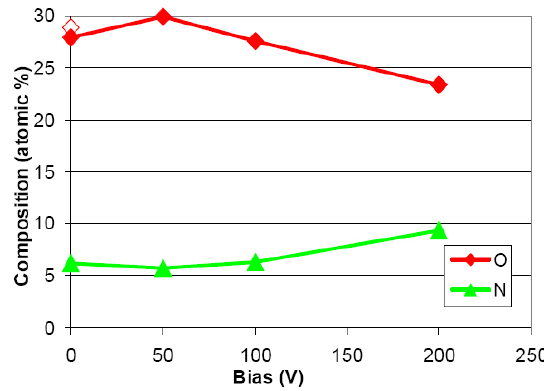
Figure 2: The surface composition of the SLGO samples, treated for 10 min, as the function of the applied bias. Open symbol represents untreated